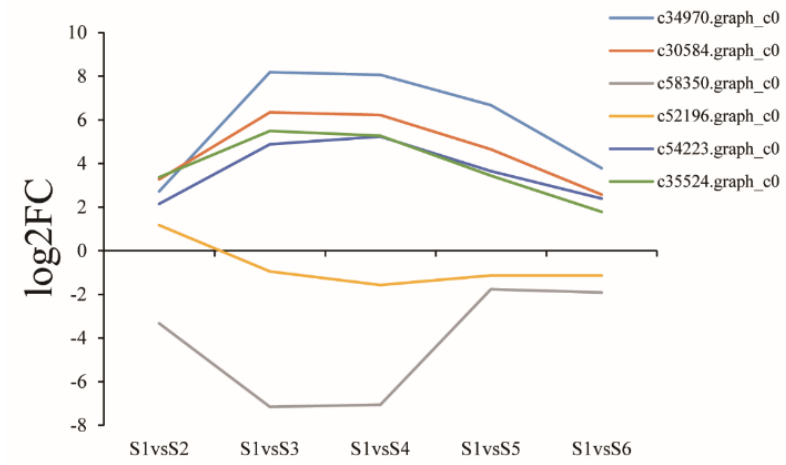
Figure 9. The log 2 of the fold change variations of sucrose synthase-related genes at five time